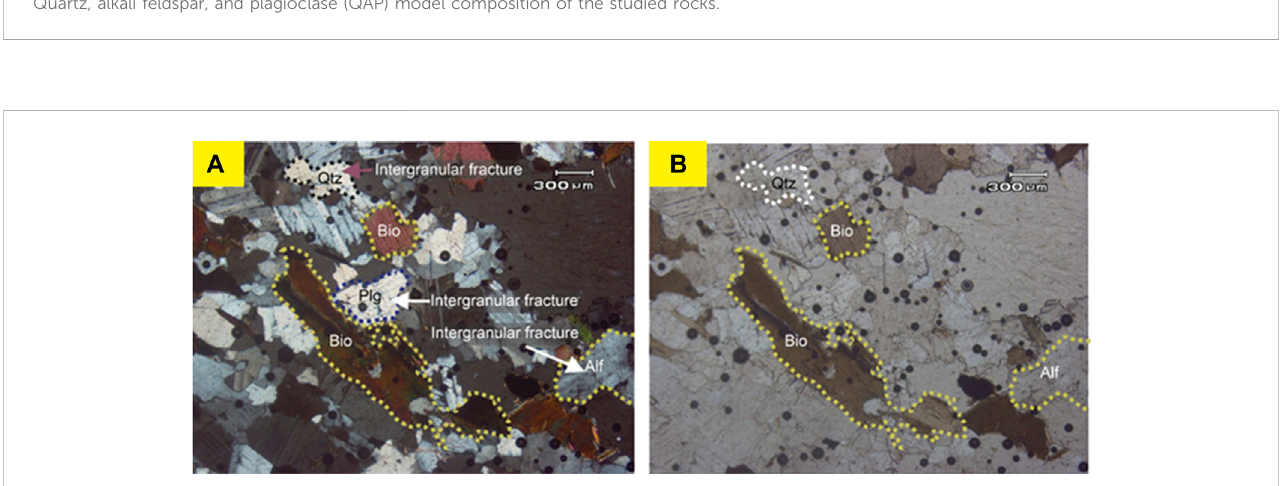
FIGURE 11 (A) Cross-polarized light(XPL)viewshowing intragranularfracture infeldspar(Alf, Plg)and quartz (Qtz)with biotite (Bio)ontheleft. (B) Photomicrograph showing the plane-polarized light (PPL) view of sample